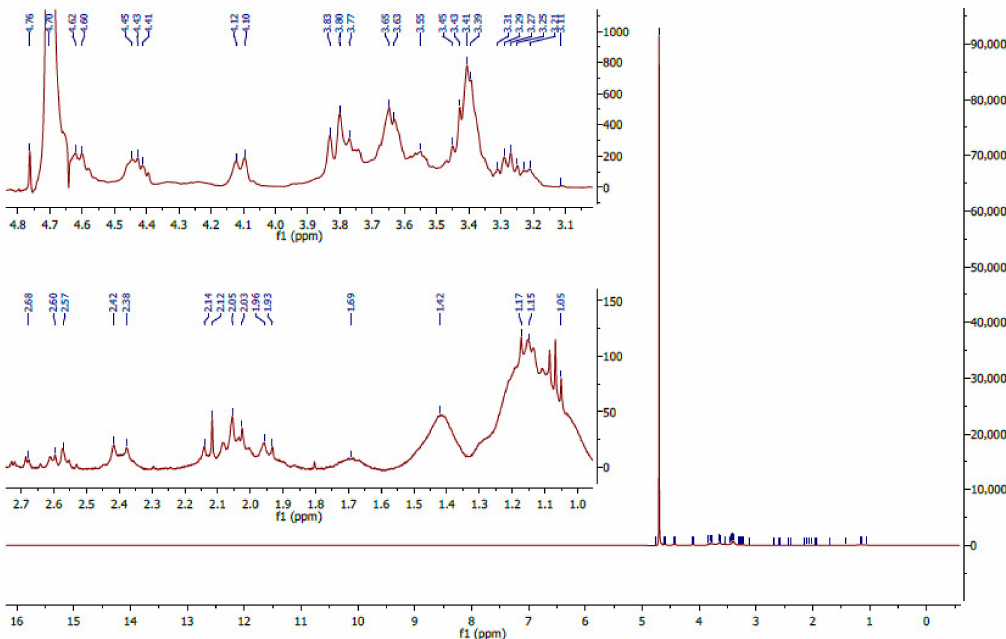
Figure 2. 1 H-nuclear magnetic resonance spectrum of E. radiata fucoidan. The spectra show peaks from 1 ppm to about 5.1 ppm, with zoom in spectra to show peaks within the regions of interest.